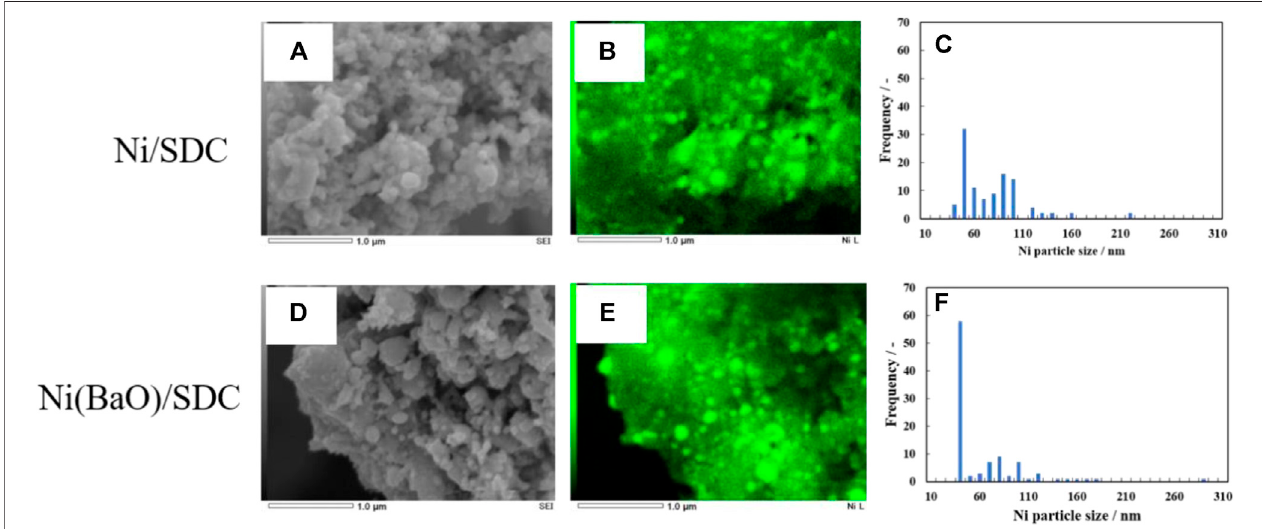
FIGURE 11 | FE-SEM pictures (A,D) , EDS elemental mappings of Ni within the FE-SEM images (B,E) , and particle size distributions of Ni scaled directly for randomly sampled 100 Ni particles in the EDS mappings (C,F) .